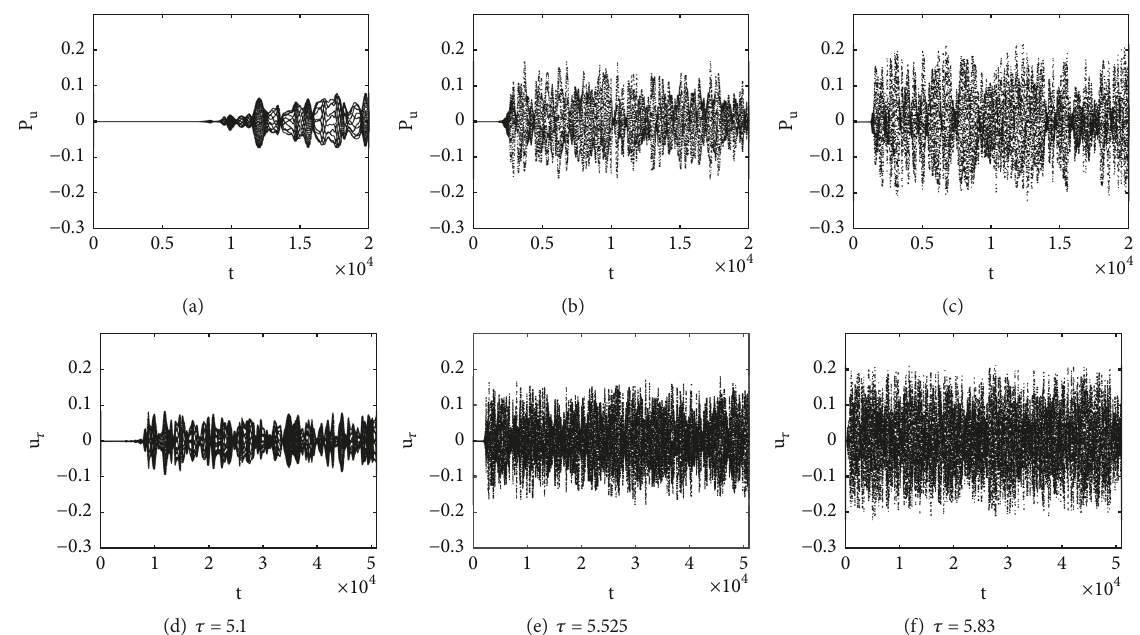
Figure 7: Sensitive analysis of pattern evolution process to variations of initial conditions (graphs a–c) and parameter 𝜏 (graphs d–f), with the application of state variables changing process in Figure